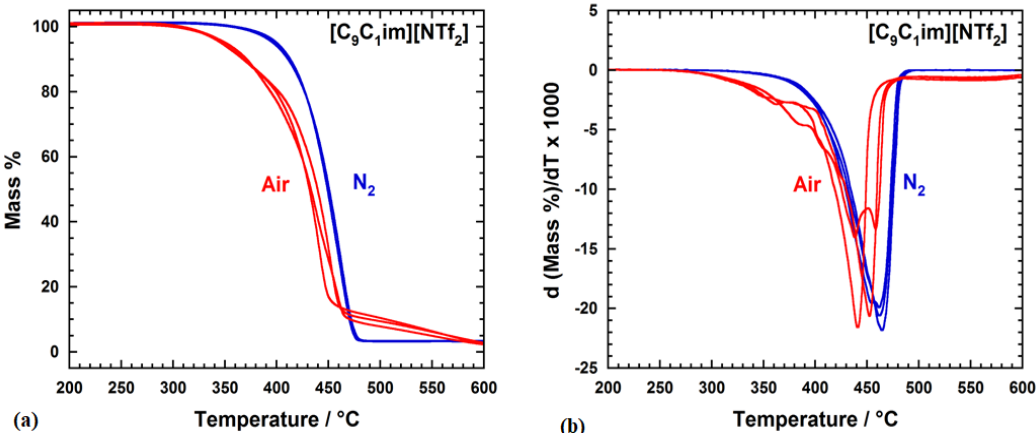
Figure 2. TGA measurement for [C 9 C 1 im][NTf 2 ]: ( a ) Dynamic TGA curves at a heating rate of 10 K / min under nitrogen and air and ( b ) TGA derivative curves obtained from Figure 2a.